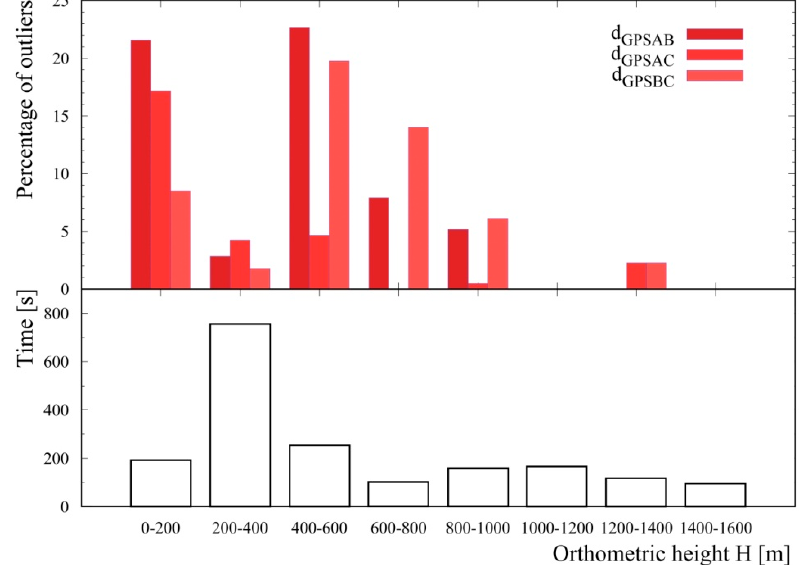
Figure 8. In the upper panel are shown the percentages of outliers identified in the d GPSAB , d GPSAC and d GPSBC datasets as function of the orthometric height H. In the bottom panel the acquisition statistics is as function of the orthometric height.